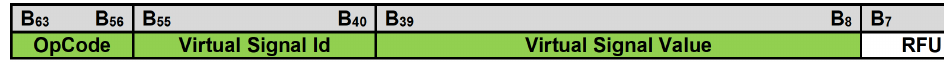
Figure 3. Proposed instruction format in the ISA of COM ASIP V2.